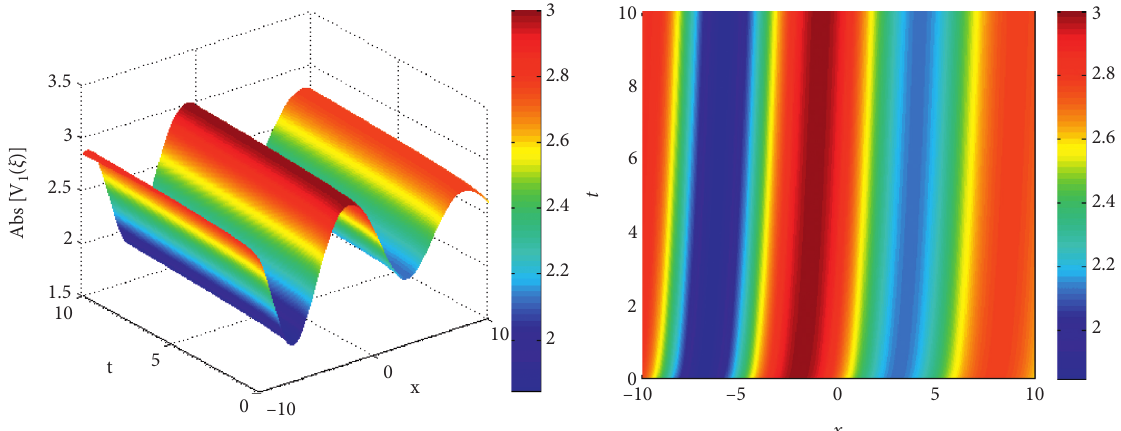
Figure 1: Soliton solutions of equation (29) in 3D and contour plots, where y � 2; k � 0.2; v � 0 . 2; α � 0.5; u � 3; λ � 4; a � 2; and c